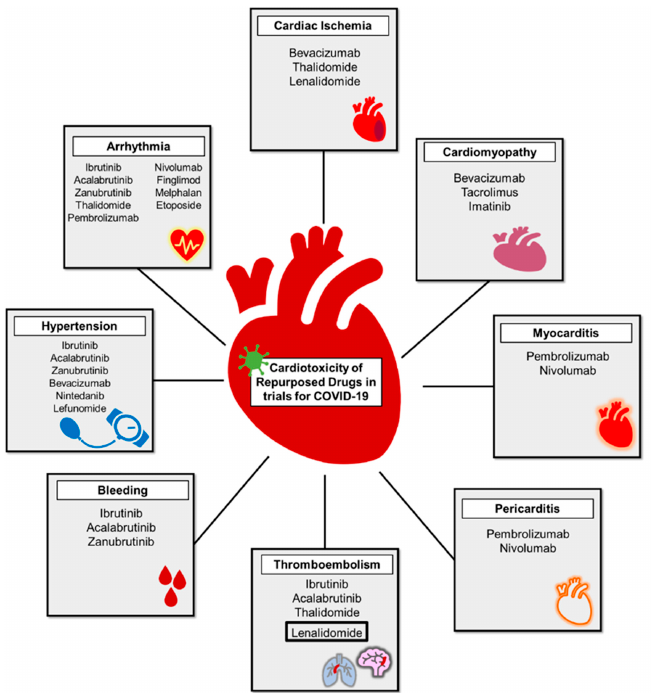
Figure 6. Cardiotoxicity of repurposed anti ‐ cancer drugs in clinical trials to treat COVID ‐ 19 related inflammation. Lenalidomide is outlined in a black box due to the US Food and Drug Administration black box warning for thromboembolism risk.